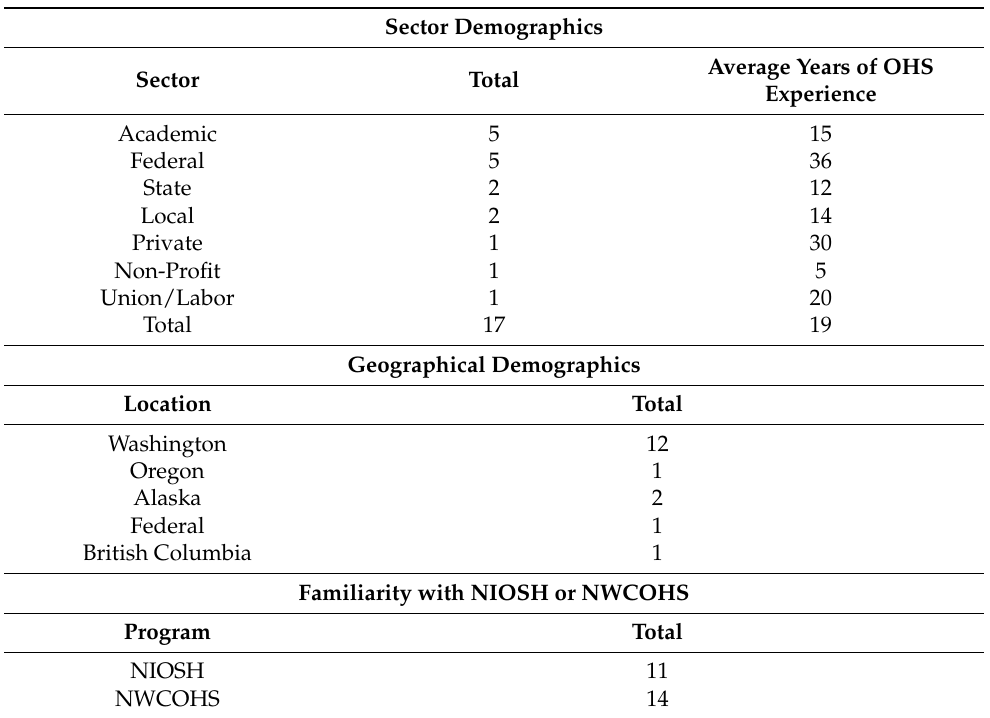
Table 1. Key informant professional